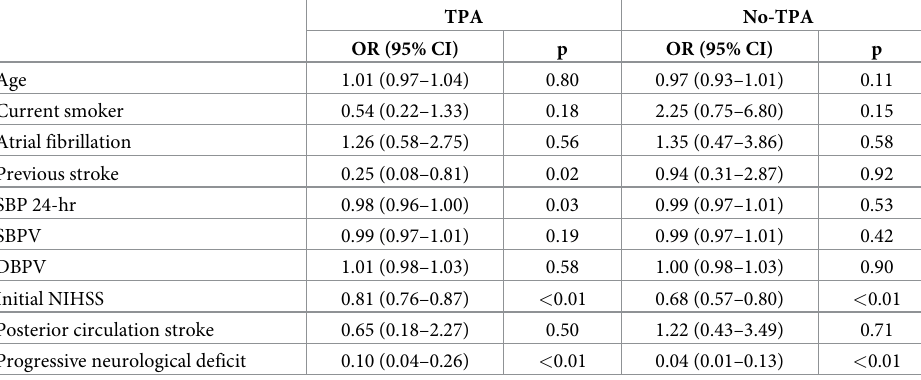
Table 2. Logistic regression analysis for favorable outcome at